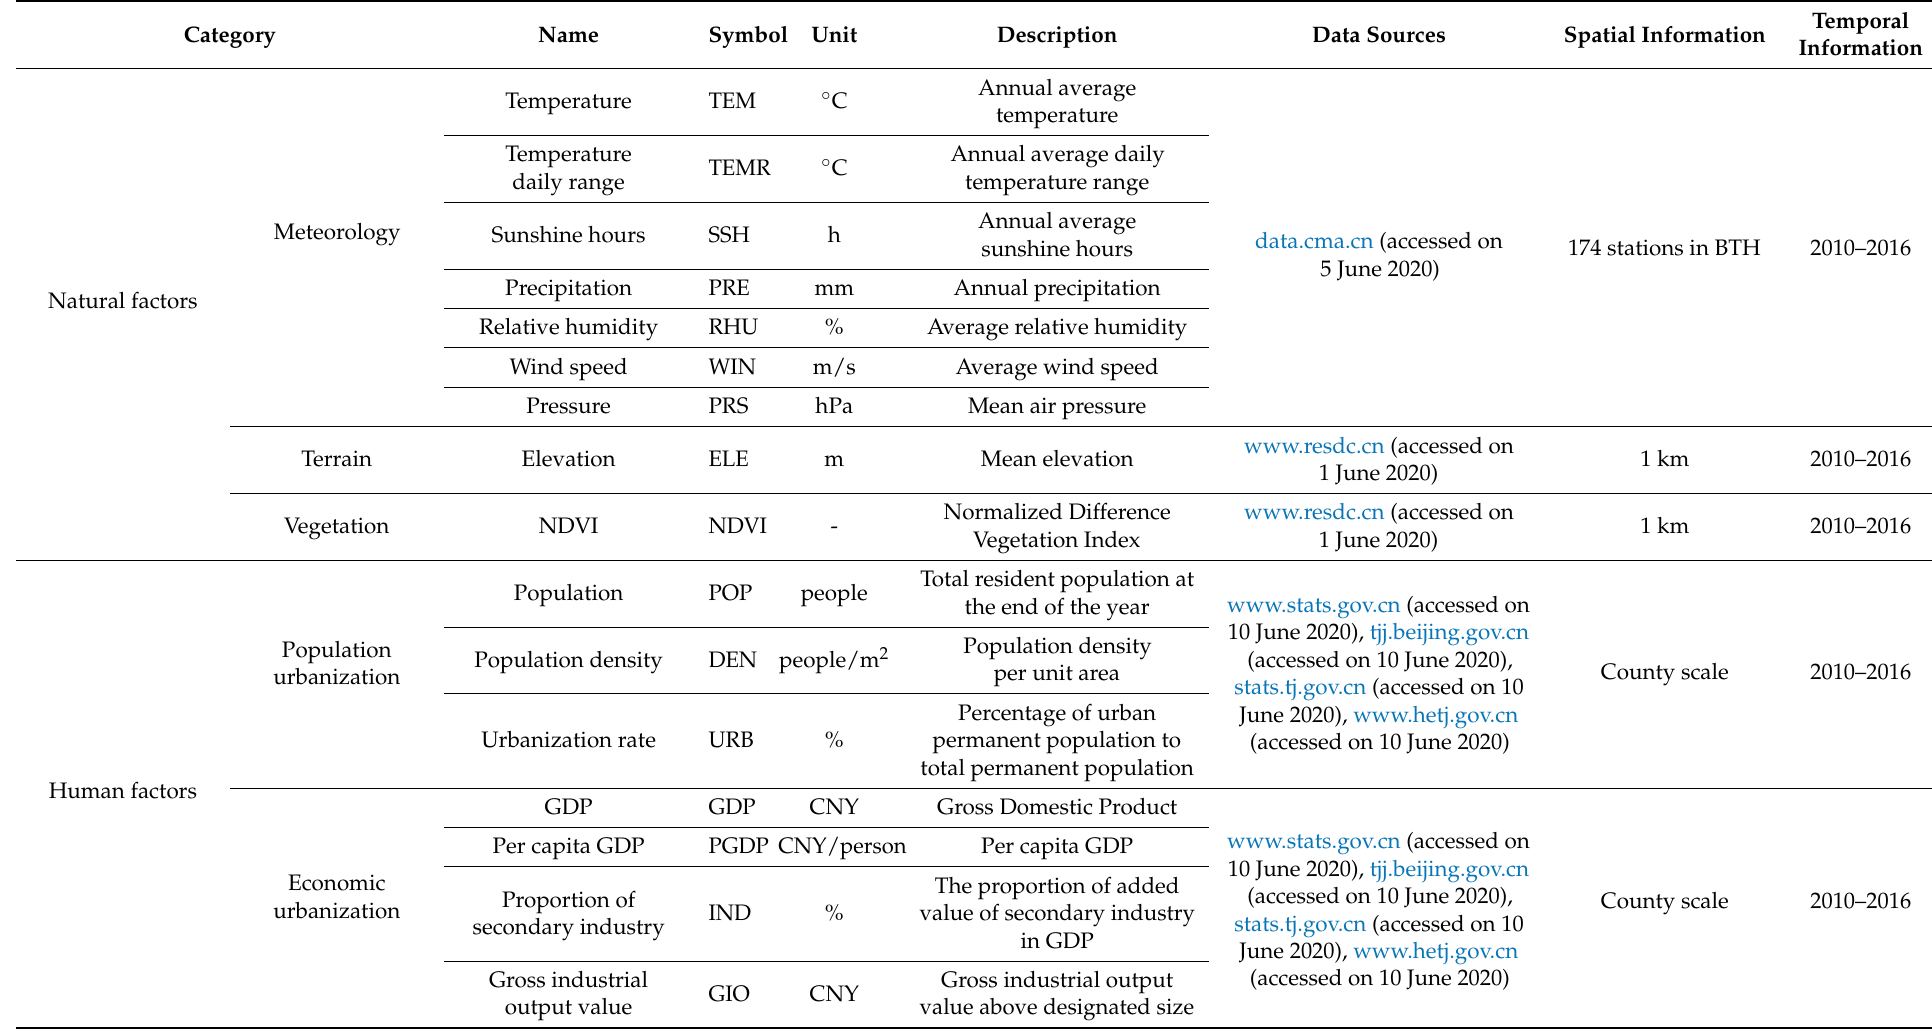
Table 1. PM 2.5 impact factor indicator